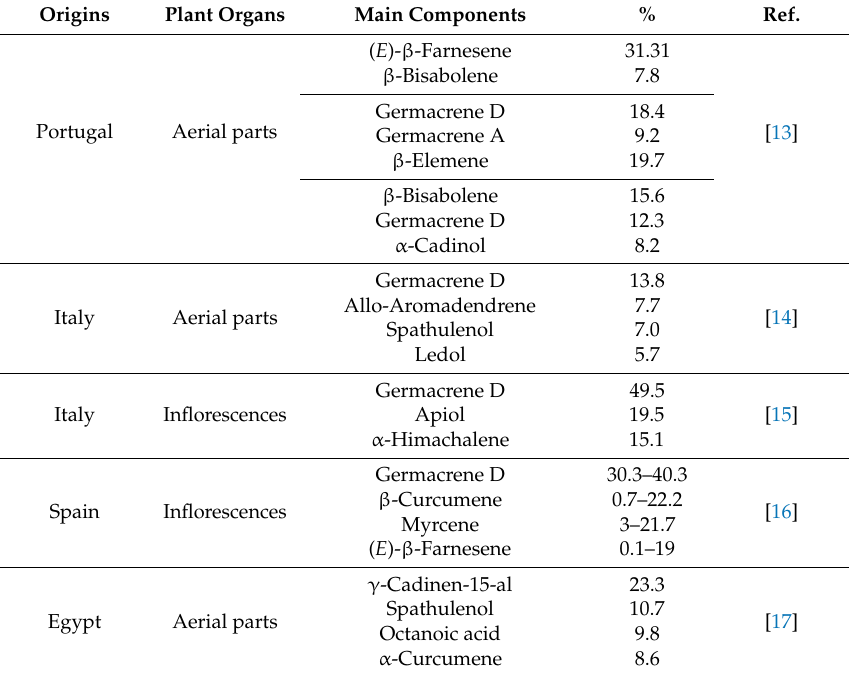
Table 1. Main components identified in E. campestre essential